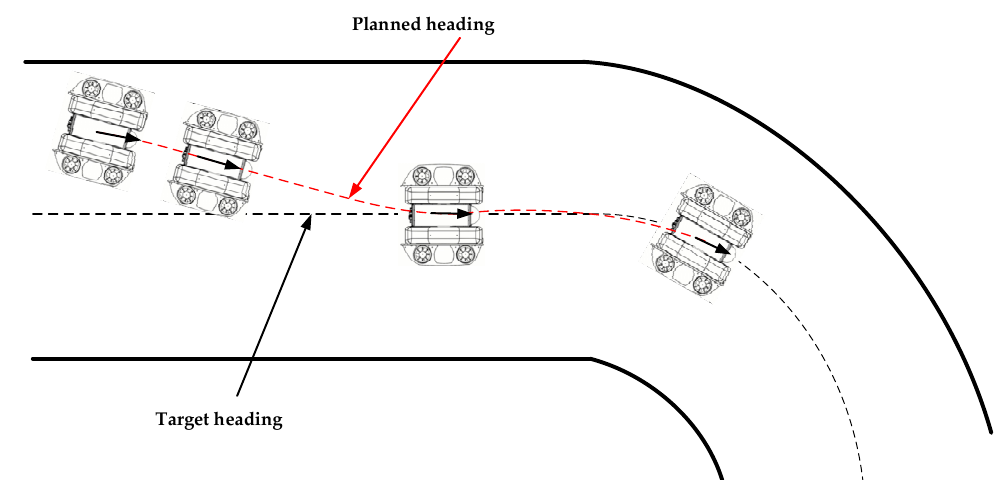
Figure 5. Schematic diagram of autonomous heading planning process.